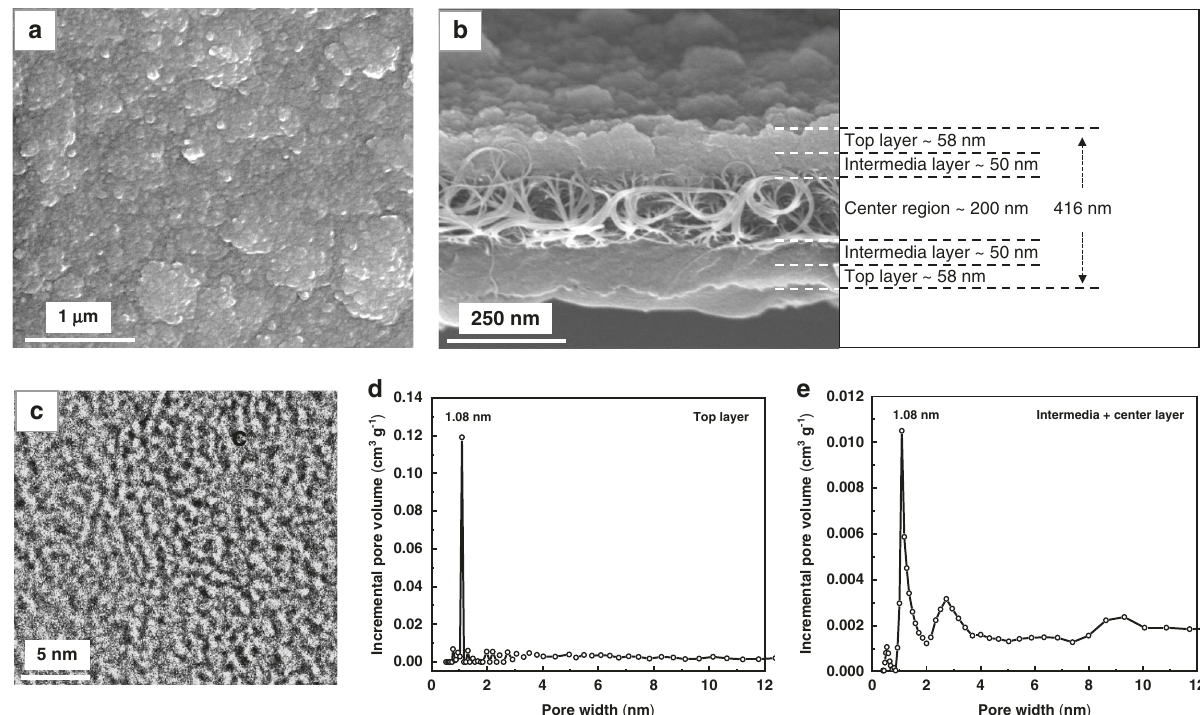
Fig. 3 Membrane structure and pore size distribution of the CNT-EP-PC15 membrane. a Top-view SEM image. b cross-section SEM image and the illustrated three membrane regions from top to the center. c TEM image of the top polycarbazole layer d Pore size distribution of the top polycarbazole layer. e Pore size distribution of the intermediate and central regions. The pore size distribution was calculated from the corresponding N 2 adsorption isotherm using the NLDFT